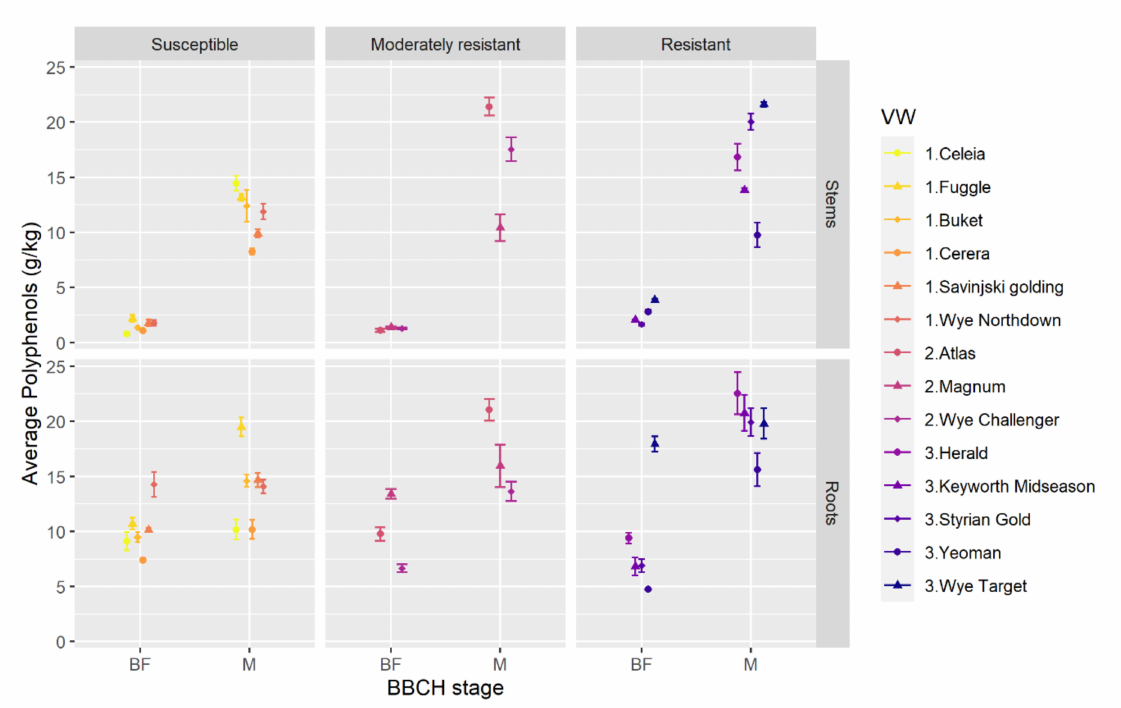
Figure 1. Average total polyphenols increase with phenological stage in di ff erent organs and hop varieties. Before flowering, hop roots have statistically significant higher average polyphenol content than stems, which is also statistically significant at the phenological stage of mature cones. Total polyphenols were determined spectrophotometrically according to the method adopted by the European Brewery Convention for determination of total polyphenols in beer [43]. Data are means ± SE ( n = 3). BF, before flowering (BBCH stage 51–55); M, mature cones (BBCH stage 87–89), VW,